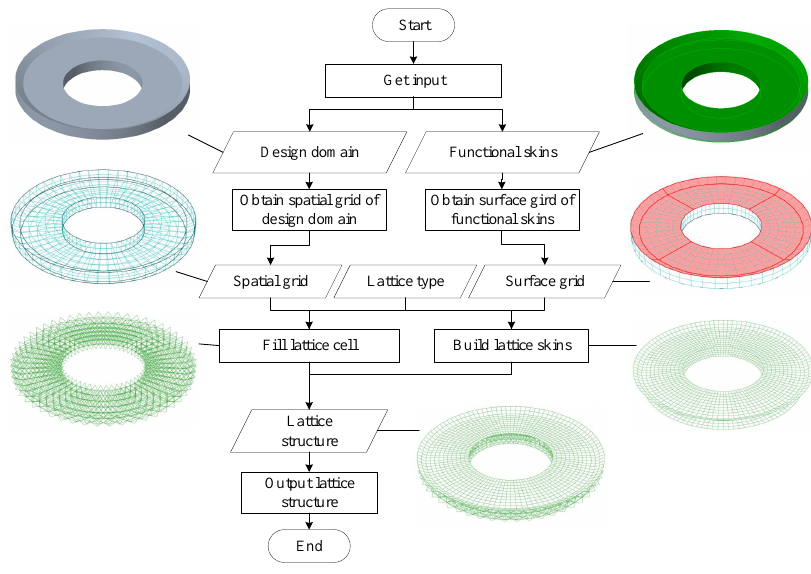
Figure 10. The process of lattice cell structure design and modeling